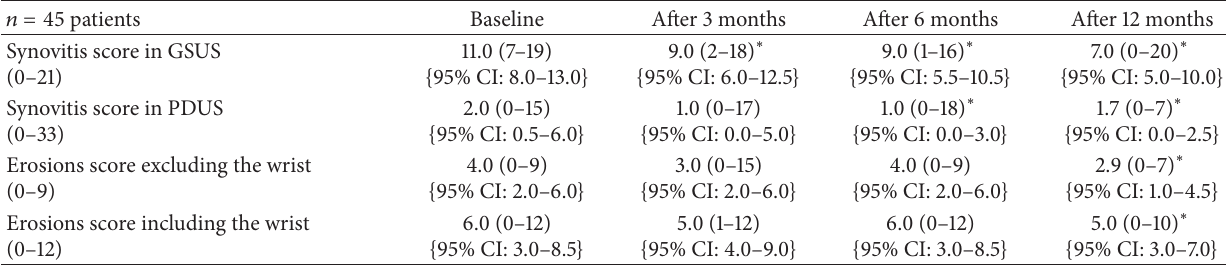
Table 2: “US5” (without forefoot results) score data over one